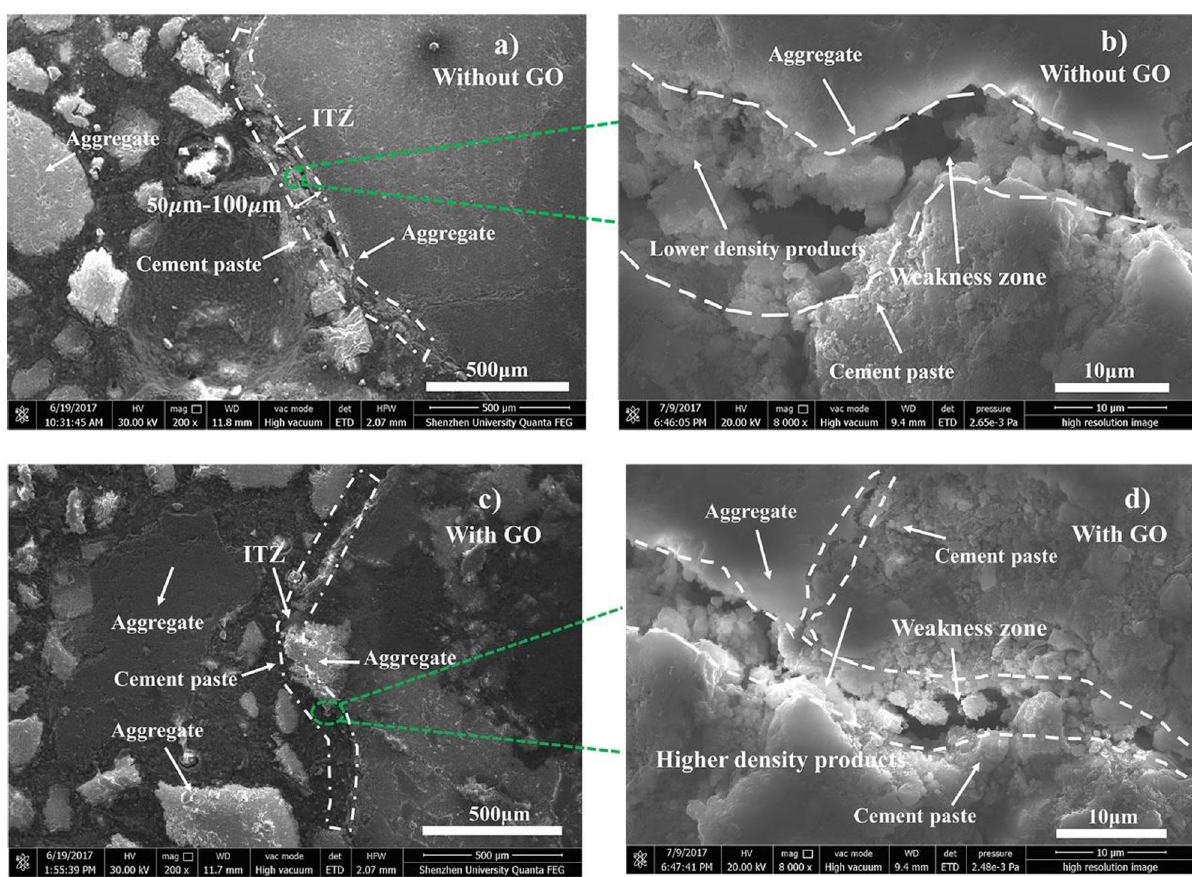
Figure 16: SEM images of crystal morphology at di ff erent magni fi cations in RFA mortar sample ( a and b ) and in RFA mortar containing GO sample ( c and d ) after 7 days curing [ 111 ] .